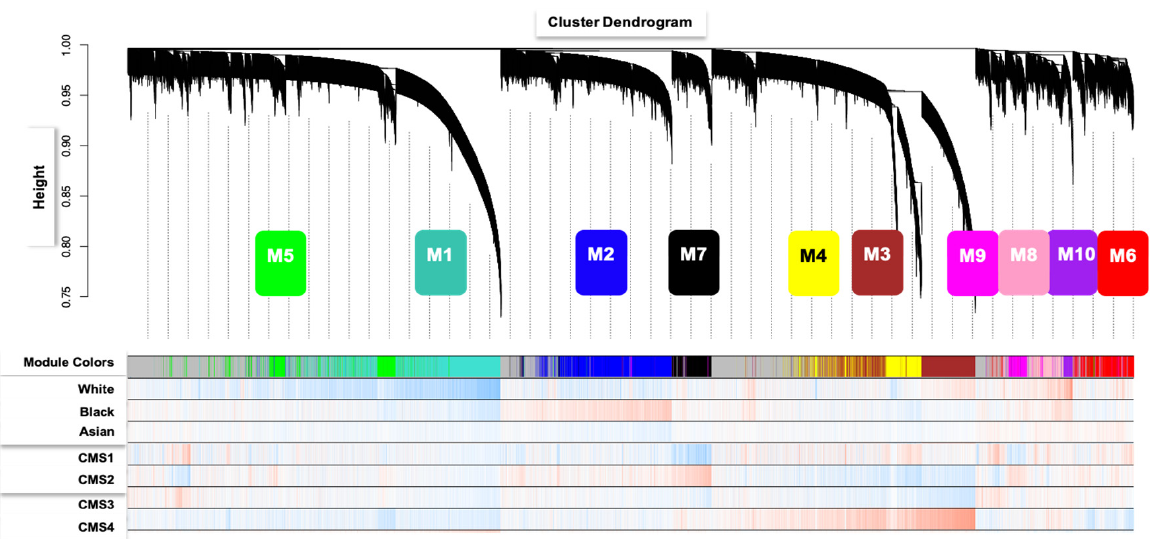
Figure 1. Gene dendrogram of clustered dissimilarity and module colors, based on consensus topological overlap. The gene dendrogram was obtained by average linkage hierarchical clustering. The module colors underneath the dendrogram show 10 module assignments determined by the Dynamic Tree Cut, which contains a group of highly connected genes. Clinical trait relationships were assessed for each color-coded module. Bypassing the default Pearson correlation method in WGCNA, we applied biweight mid-correlation as a robust alternative implemented in the WGCNA function (bicor). Module color bicor color scale ( − 1, blue; 0, white; +1, red) represents modules with significant student’s p cluster. To identify clinical associations, module expression was correlated (bicor-rho) with quantitative and qualitative clinical traits. Co-expression modules M6 (red), M8